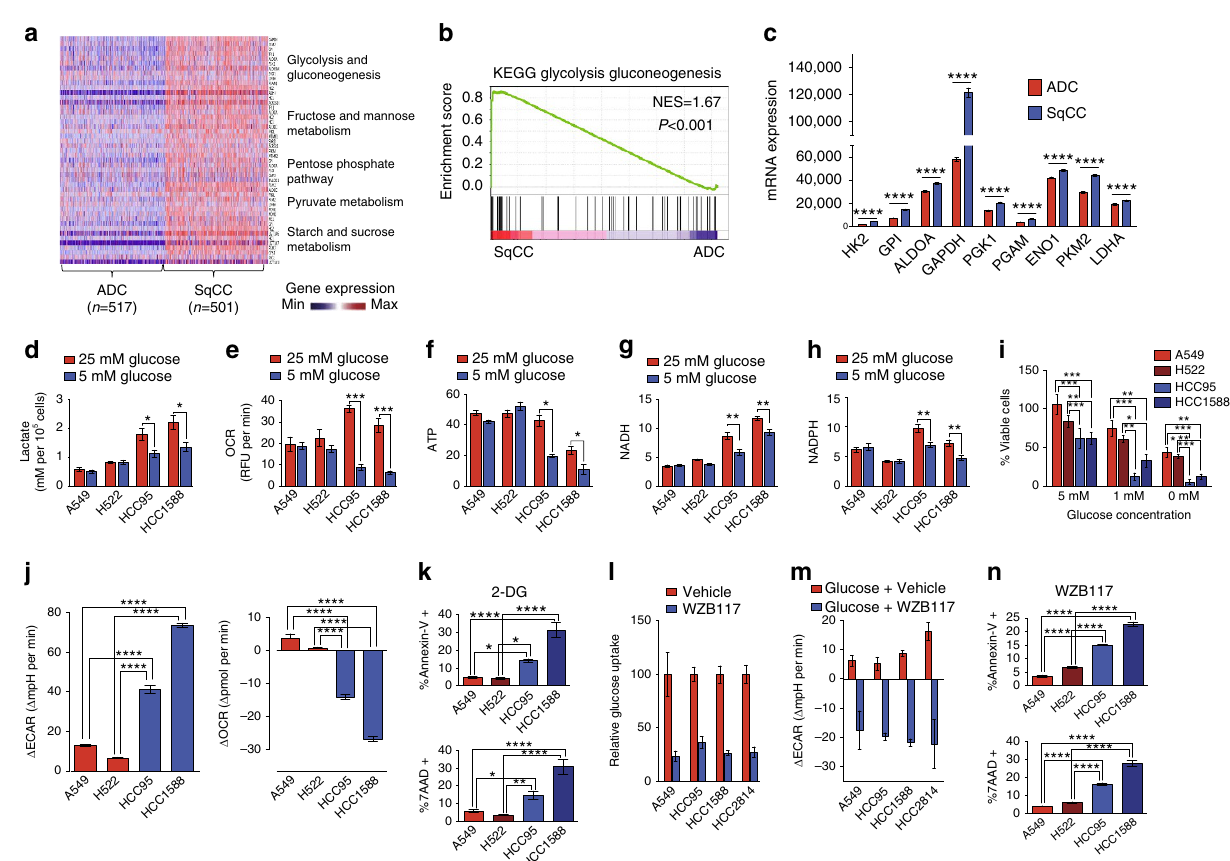
Figure 4 | Lung SqCC relies on glucose for cellular bioenergetics. ( a ) Heatmap depicting expression distribution of genes from the highlighted metabolic gene sets enriched in the TCGA cohort of SqCC patients. ( b ) GSEA mountain plot depicting significantly enriched glycolytic gene expression as defined by the KEGG gene set. P o 0.001; NES, normalized enrichment score. ( c ) Glycolytic gene expression (normalized TPM) of TCGA SqCC ( n ¼ 501) and ADC ( n ¼ 517) patients. Mann–Whitney u -test, **** P o 0.0001. ( d , e ) Extracellular lactate concentration ( d ) and O 2 consumption rate ( e ) in ADC (A549 and H522) and SqCC (HCC95 and HCC1588) cell lines cultured in 25 and 5mM glucose concentrations for 24h ( n ¼ 6–9 each group from two to three biologically independent experiments). Two-tailed t -test, *** P o 0.001, * P o 0.05. ( f – h ) Comparison of relative intracellular ATP ( f ), NADH ( g ) and NADPH ( h ) between cells cultured in 25 and 5mM glucose concentrations for 24–72h ( n ¼ 9 each group from three biologically independent experiments). Two- tailed t -test, ** P o 0.01, * P o 0.05. ( i ) Cell viability of ADC and SqCC cell lines cultured in decreasing glucose concentrations for 72–96h ( n ¼ 3–4 each group from at least two biologically independent experiments). One-way ANOVA *** P o 0.001, ** P o 0.01, * P o 0.05. ( j ) Extracellular acidification rate